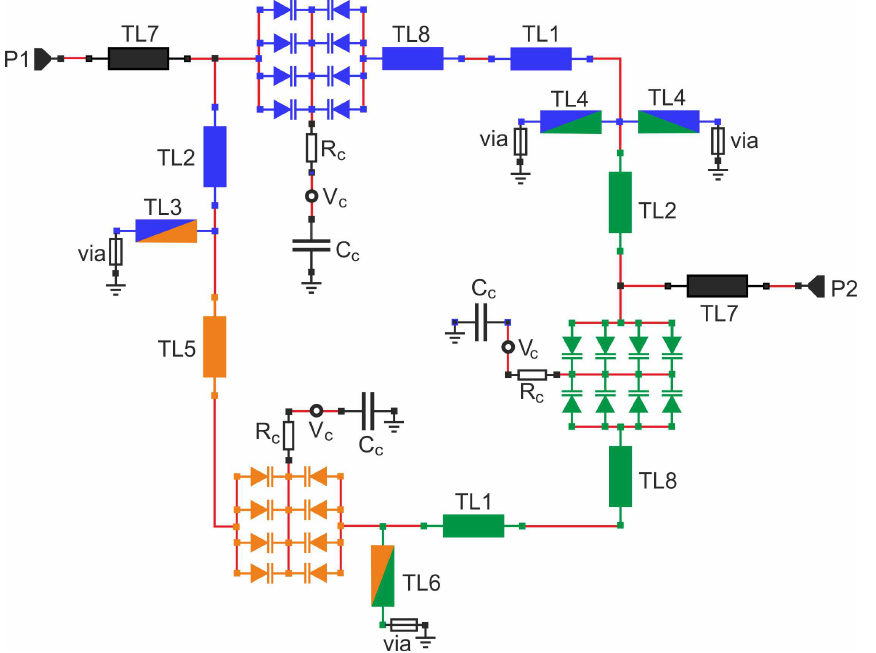
Figure 9. Transmission line implementation of the tunable TTMC filter. Table 1. Initial values of transmission lines of the filter from Figure